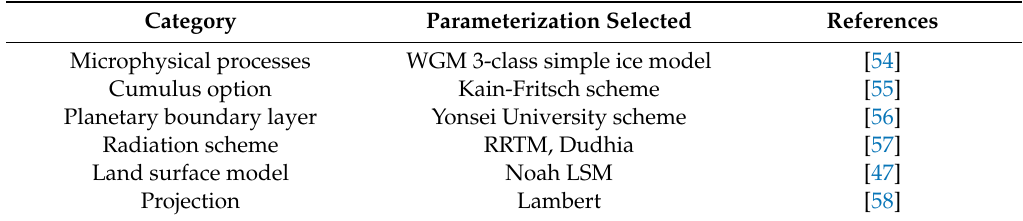
Table 2. Physical parameterizations of the WRF